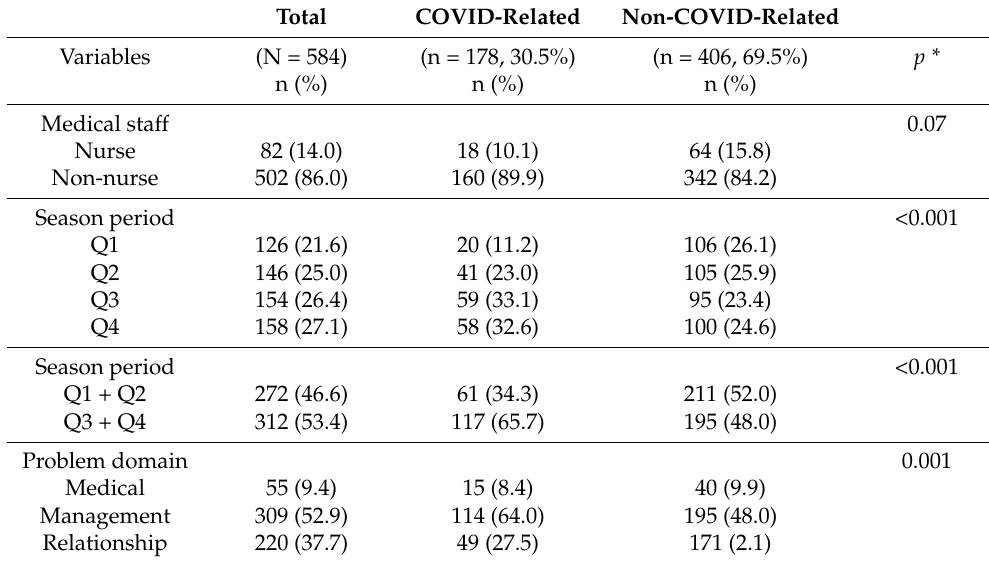
Table 2. Analysis of the healthcare complaints analysis tool domains and problems according to COVID-19-related and non-related